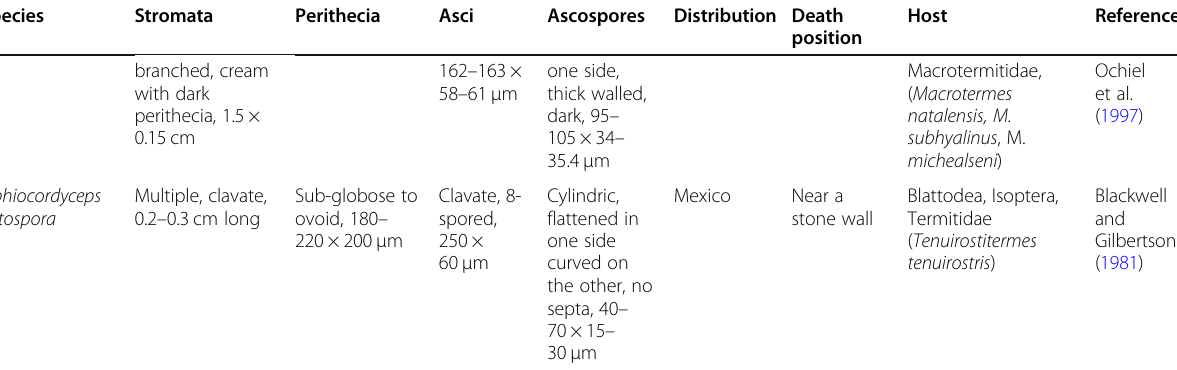
Table 2 Morphological and ecological comparison between Ophiocordyceps species associated with blattodean insects (termites and cockroaches)